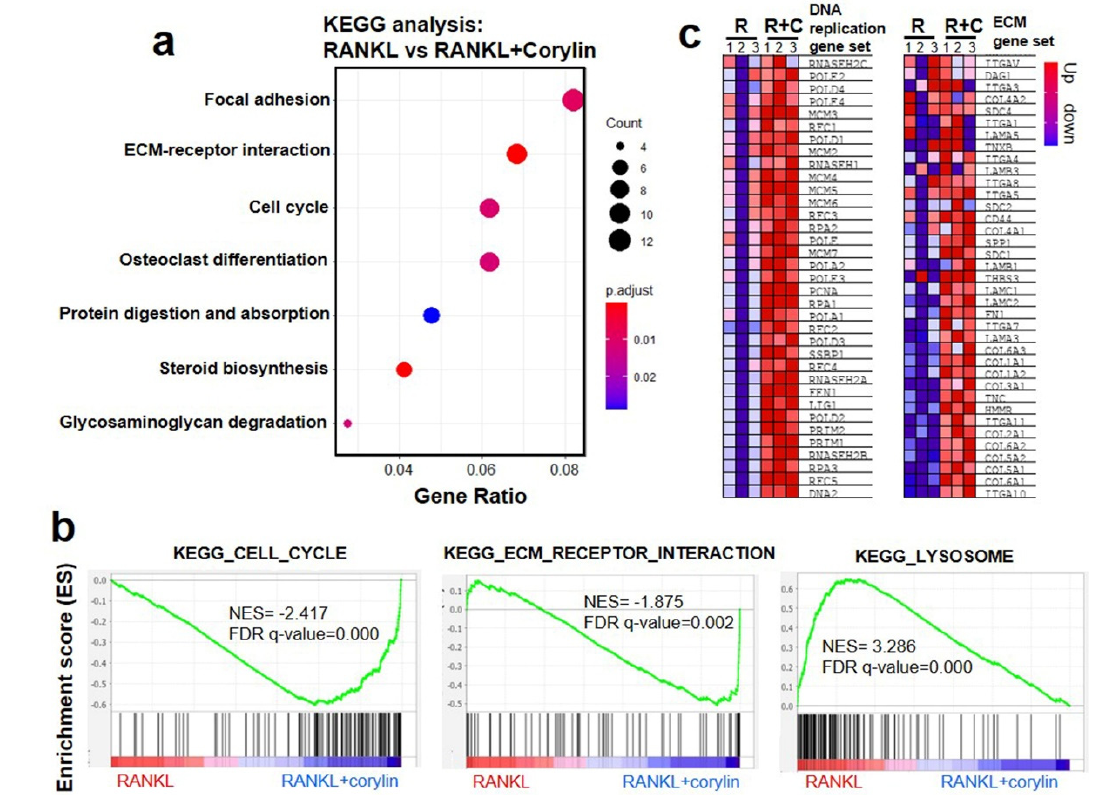
Figure 4. Transcriptomics of corylin-treated pre-osteoclasts. ( a ) Kyoto Encyclopedia of Genes and Genomes (KEGG) analysis of enriched signaling pathways in bone marrow macrophages treated with corylin for 4 days. The gene ratio is the ratio of DEG numbers to all gene numbers in a specific pathway. P -adjusted value is the corrected p value, ranging from 0 to 1. A greater rich factor and less P -adjusted value means a greater impact on the signaling pathway. ( b ) Gene set enrichment analysis (GSEA) enrichment plots using the KEGG gene set of an enriched “cell cycle” (normalized enrichment score (NES) = 2.417, false discovery rate (FDR) q -value < 0.000) and “ECM–receptor interaction” (NES = 1.875, FDR q -value < 0.002) in the RANKL group compared with RANKL + corylin group; meanwhile, the gene set related to lysosomes was enriched in RANKL (NES = 3.286, FDR q -value < 0.002) and down-regulated in the presence of corylin. Enrichment plots reveal the profile of the running enrichment score and positions of GeneSet members on the rank ordered list. ( c ) Heat map of the top features for each phenotype in gene expression. GSEA collapsed to gene symbols, representing a clustering of mRNA expression levels in cells treated with RANKL (R) or RANKL + corylin (R+C). Each column represents the indicated sample; each row indicates one gene. Expression values are represented as colors, where the range of colors (red, pink, light blue, dark blue) shows the range of expression values (high, moderate, low, lowest, respectively).